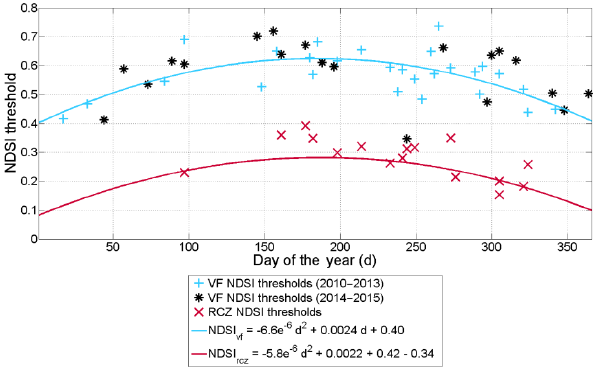
Figure 8. Estimates of NDSI threshold values at VF are predicted by a quadratic polynomial model (NDSI vf , blue line) which was fitted for each day of the year to the calibrated NDSI thresholds be- tween 2010 and 2013 (NDSI thr , blue pluses). The black asterisks represent the NDSI thr from 2014 to 2015 at VF used for evalua- tion of NDSI vf . Additionally, an NDSI thr prediction model for RCZ (NDSI rcz , red line) is defined by a quadratic polynomial model fit- ted to the complete time series of calibrated NDSI thr at VF (blue pluses and black asterisks, r 2 = 0.36, RMSE = 0.07) and an addi- tional term of − 0.34. NDSI rcz is evaluated against the calibrated NDSI thr of RCZ (red